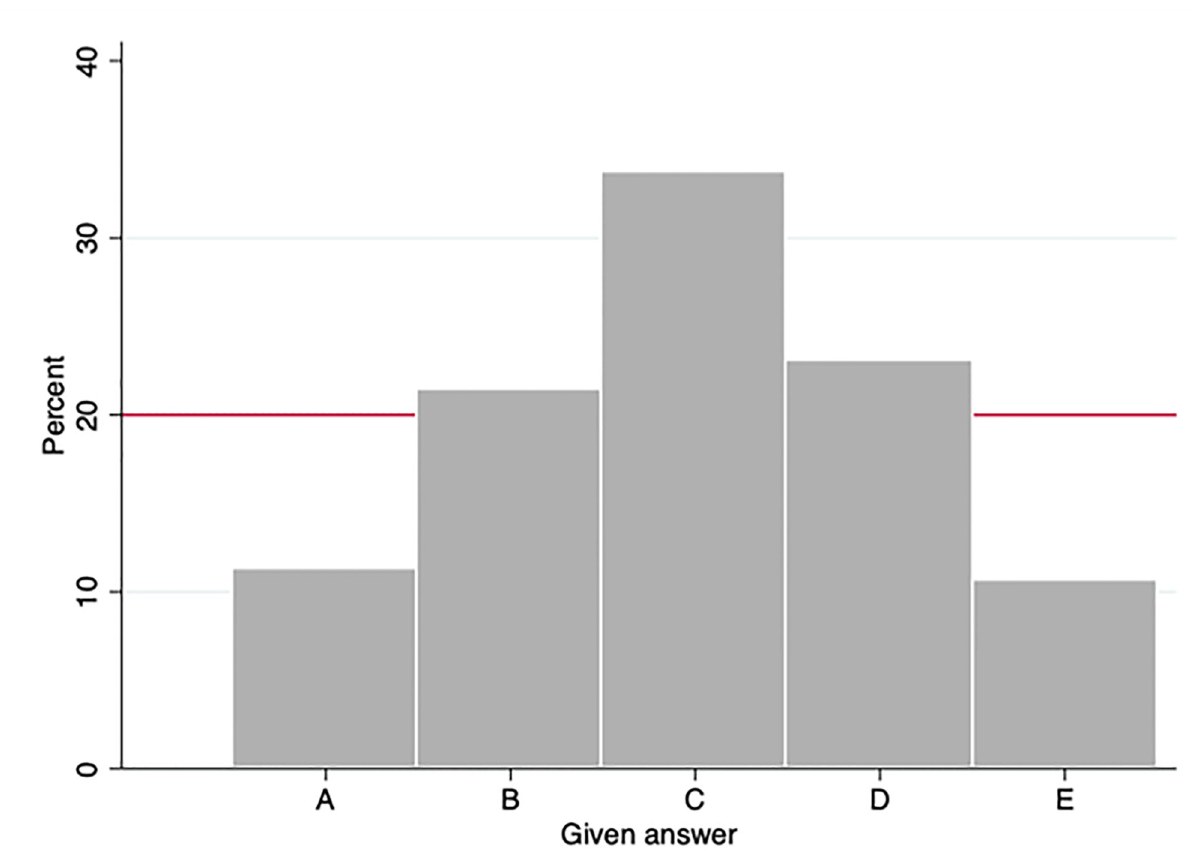
Fig 1. Answers provided by subjects in Ex